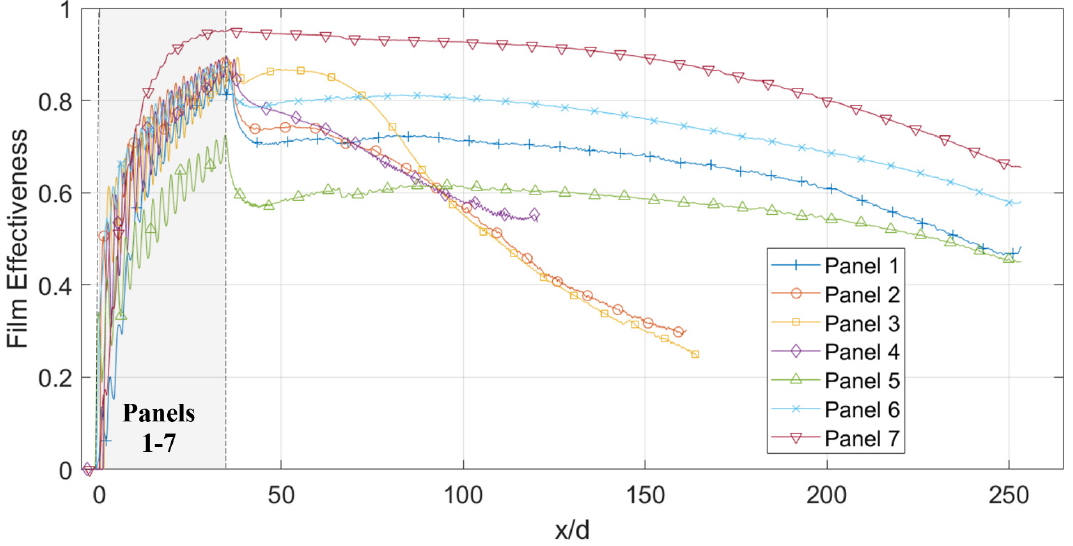
Figure 11. Spanwise average of all Panels at 15 g/s